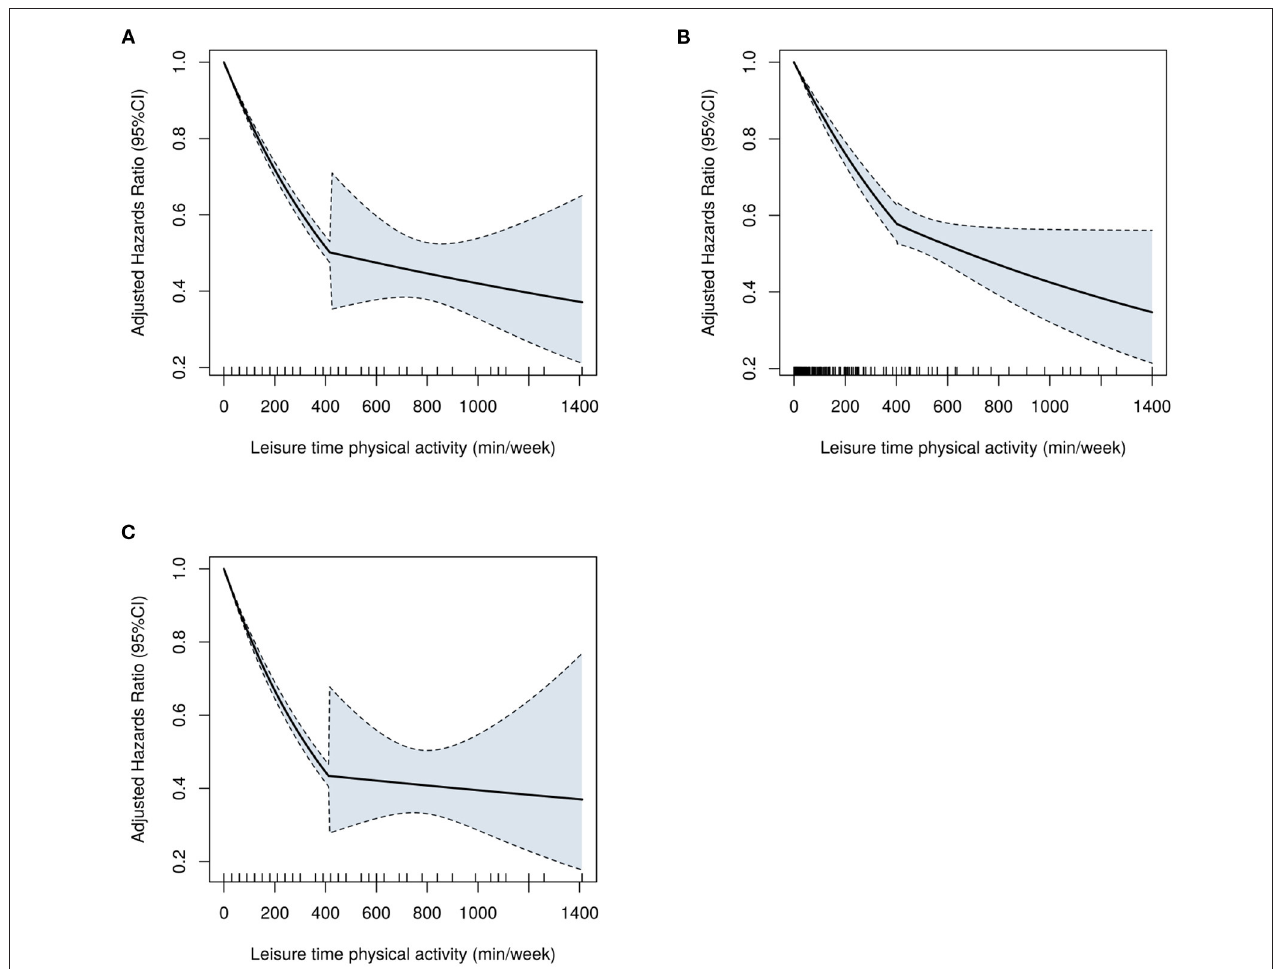
FIGURE 3 | The piecewise-linear relationships between LTPA with (A) CVD, (B) CHD, and (C) CBD, which were estimated by the segmented regression. CVD, cardiovascular disease; CHD, coronary heart diseases; CBD, cerebrovascular diseases; LTPA, leisure time physical